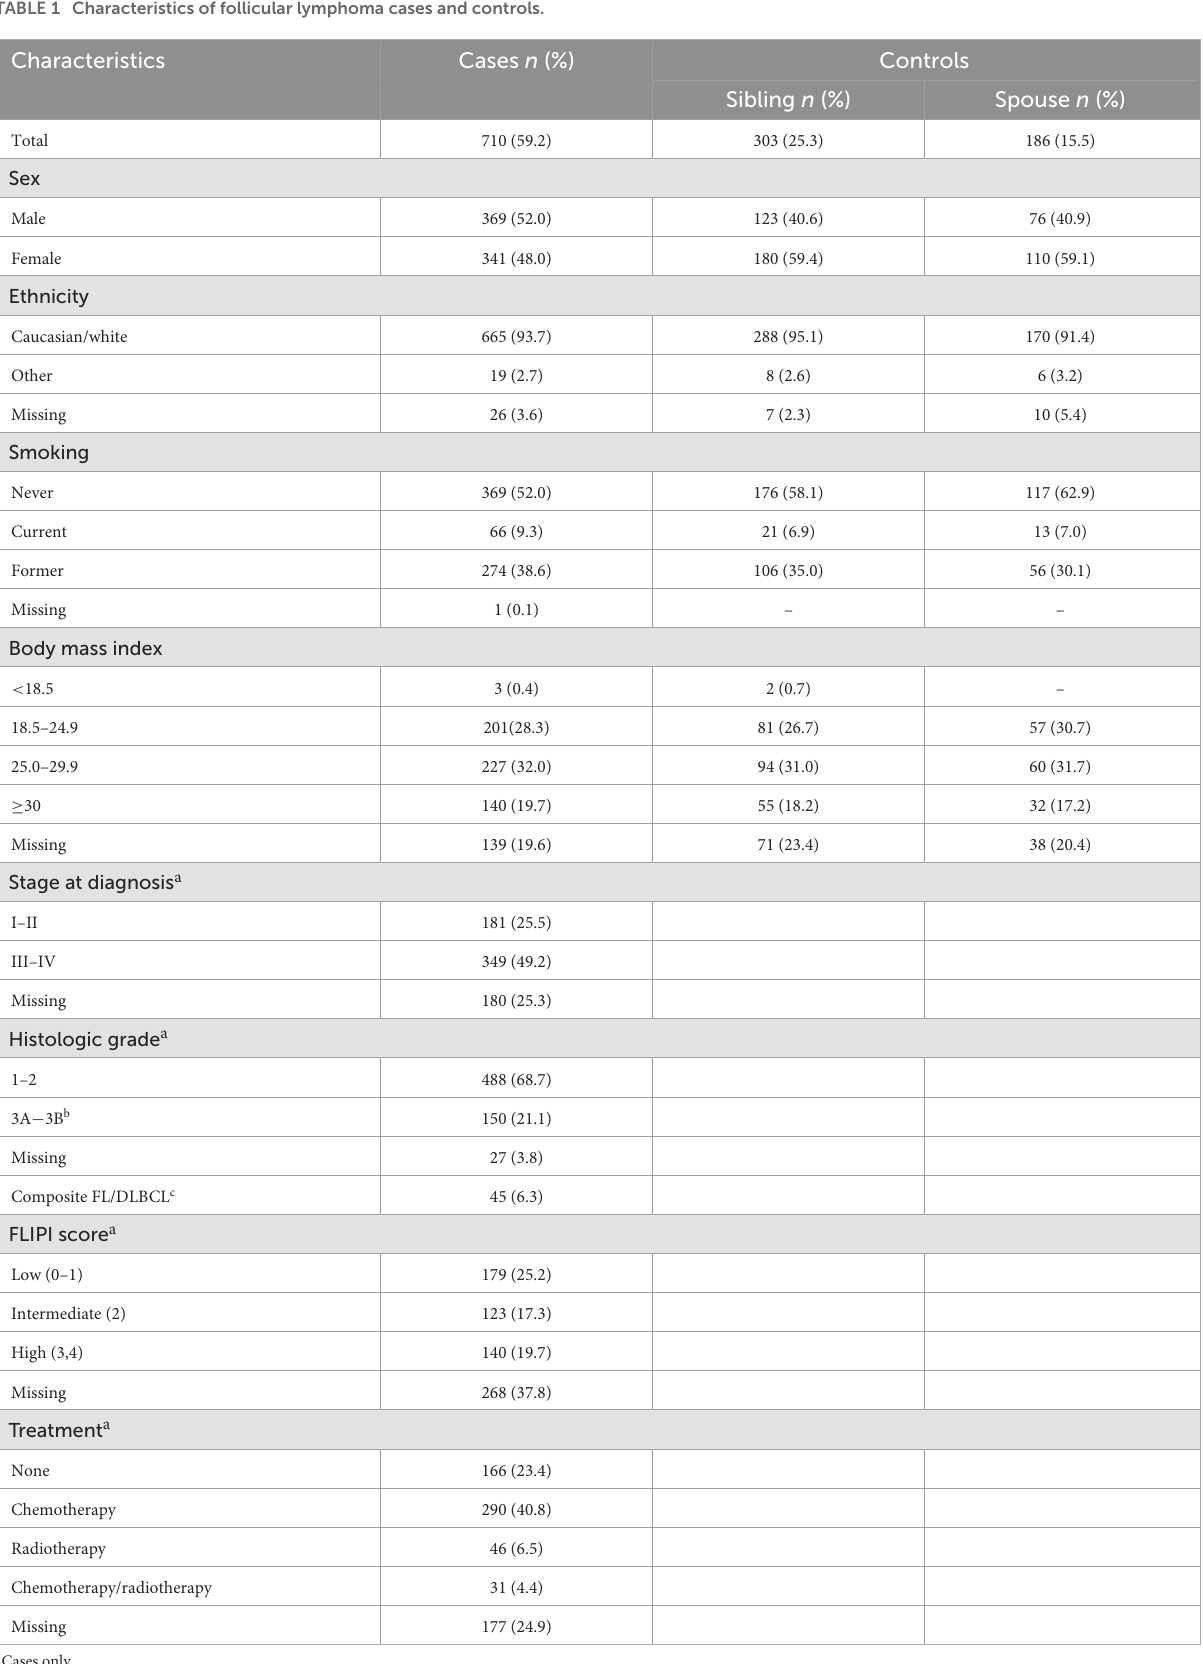
TABLE 1 Characteristics of follicular lymphoma cases and